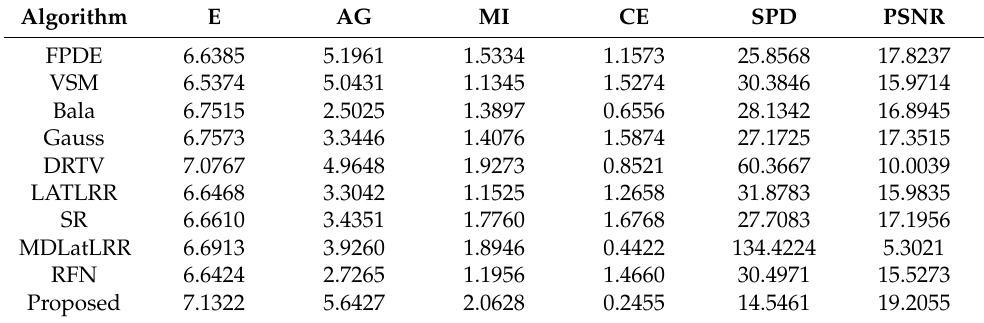
Table 2. Quantitative comparison results of the ten methods on ‘2_Men in front of house’ image.